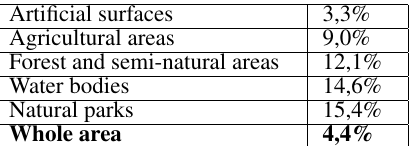
Figure 2. Time series of total users’ movements observed in Table 1. Representativeness of the average Facebook users’ each CLC class and natural park areas of the Insubria region. population, expressed as a percentage of the estimated resident Records are provided every 8 hours. population in the Insubria region per CLC classes and natural park areas. The resident population is estimated using the 2015 GHS-POP raster grid at 250 m resolution (Schiavina et al., 2019).